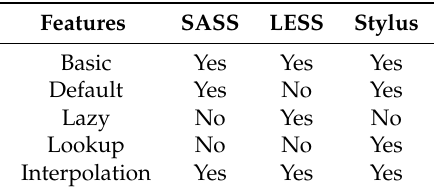
Table 3. Variables features comparison.